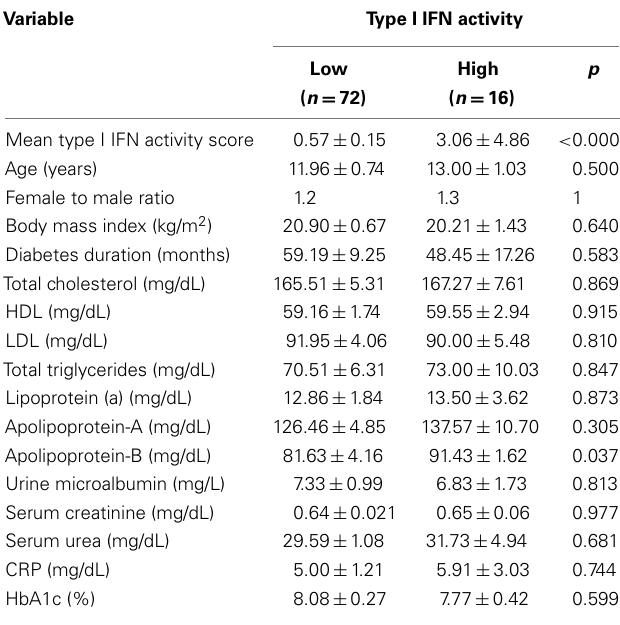
Table 4 | Comparison ofTIDM patients with low or high type I IFN activity in bivariate